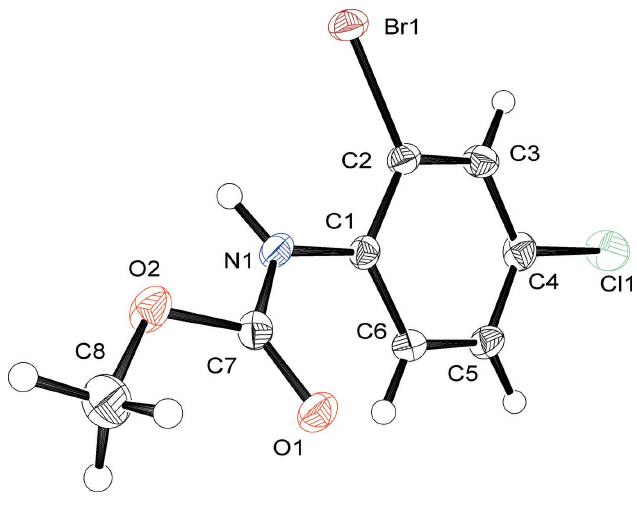
Figure 1 An ORTEP representation (50% probability level) of the title molecule.